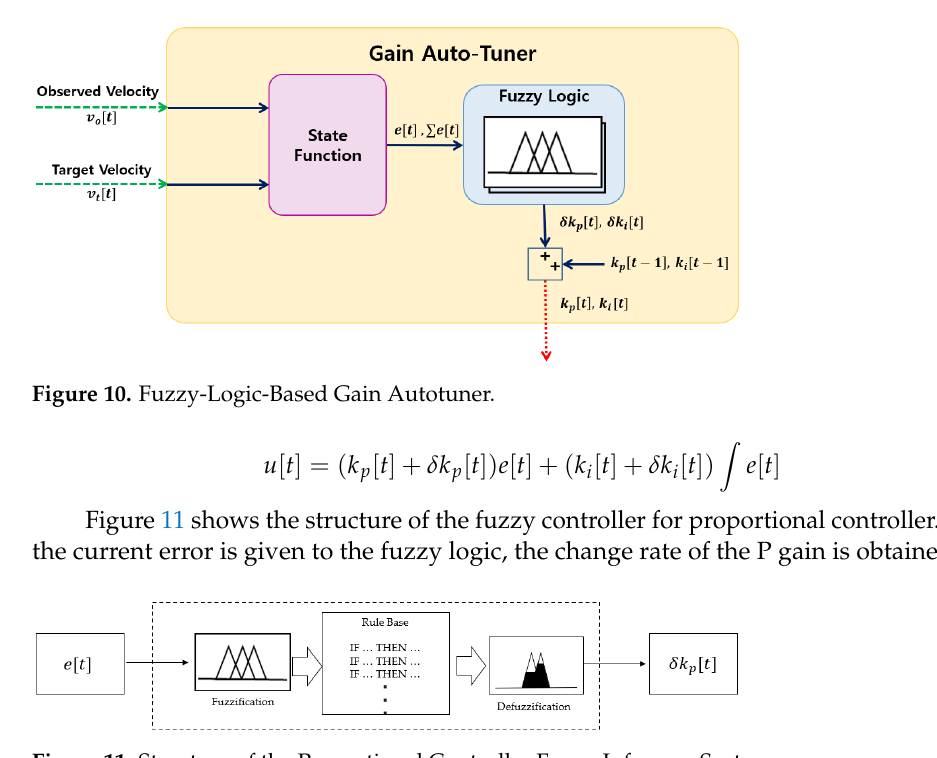
Figure 11. Structure of the Proportional Controller Fuzzy Inference